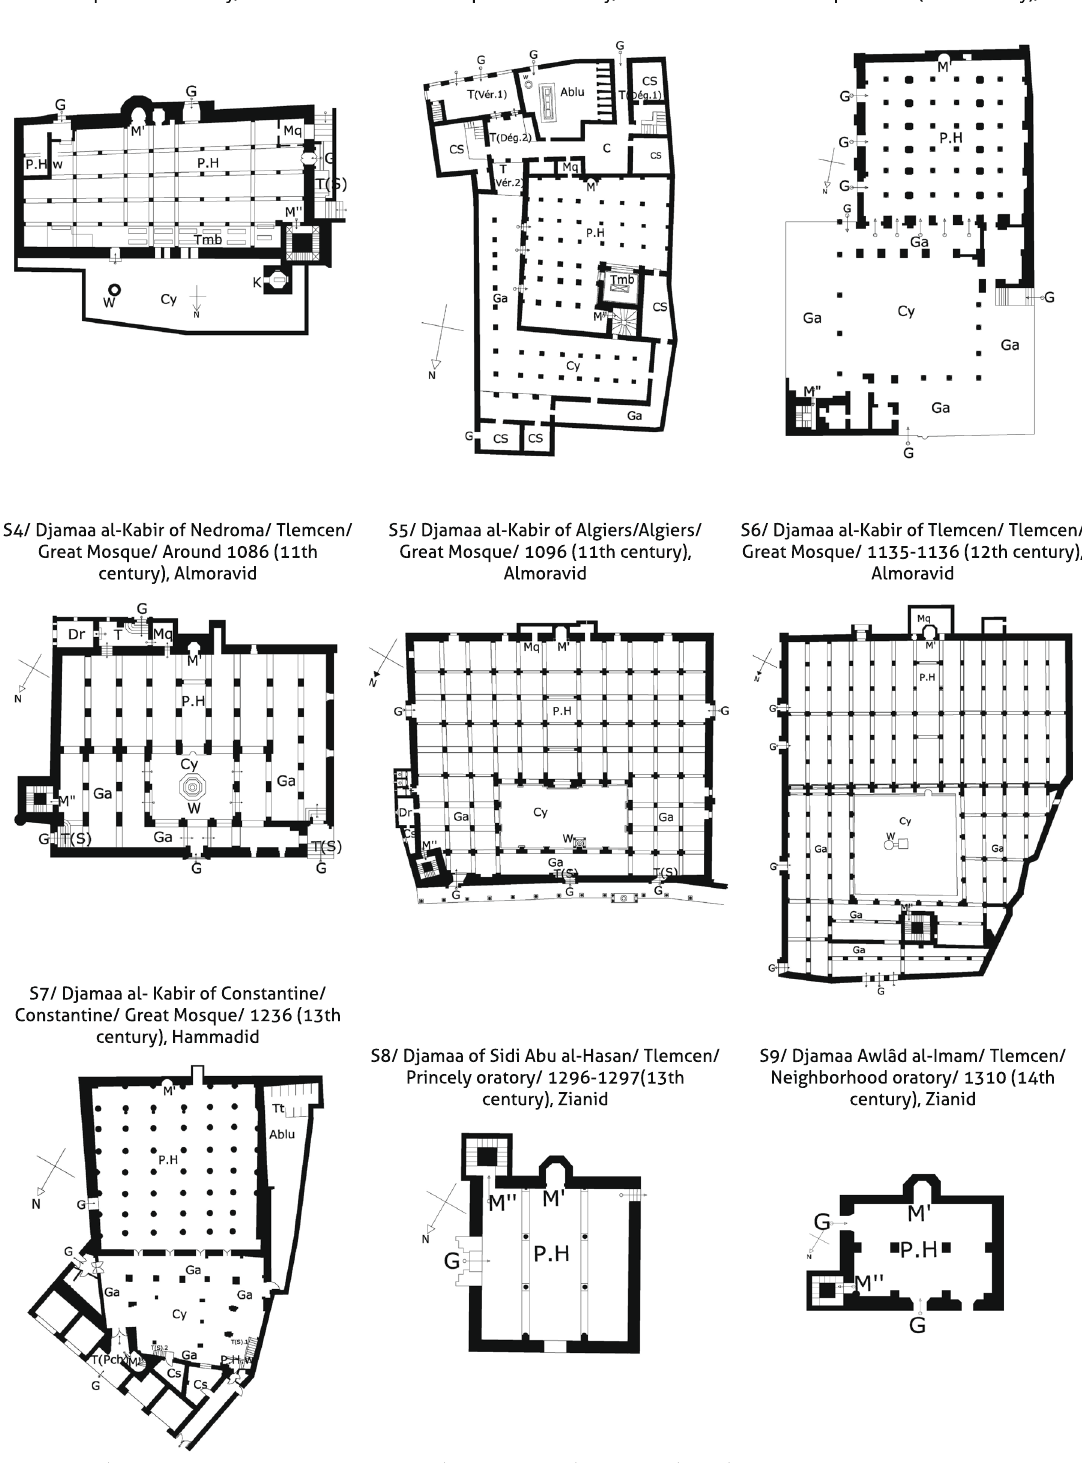
Fig. 3 Corpus study (S1–S9): Mosque/ Location/ Type/ Period construction/ Plan (Source: the